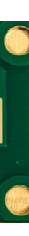
Figure 7. Sintered bare die MOSFET on ENIG metallized copper plate with FR4 adapter PCB holding the probing pads for ATIM and Al wire bonds to the MOSFET top contacts.